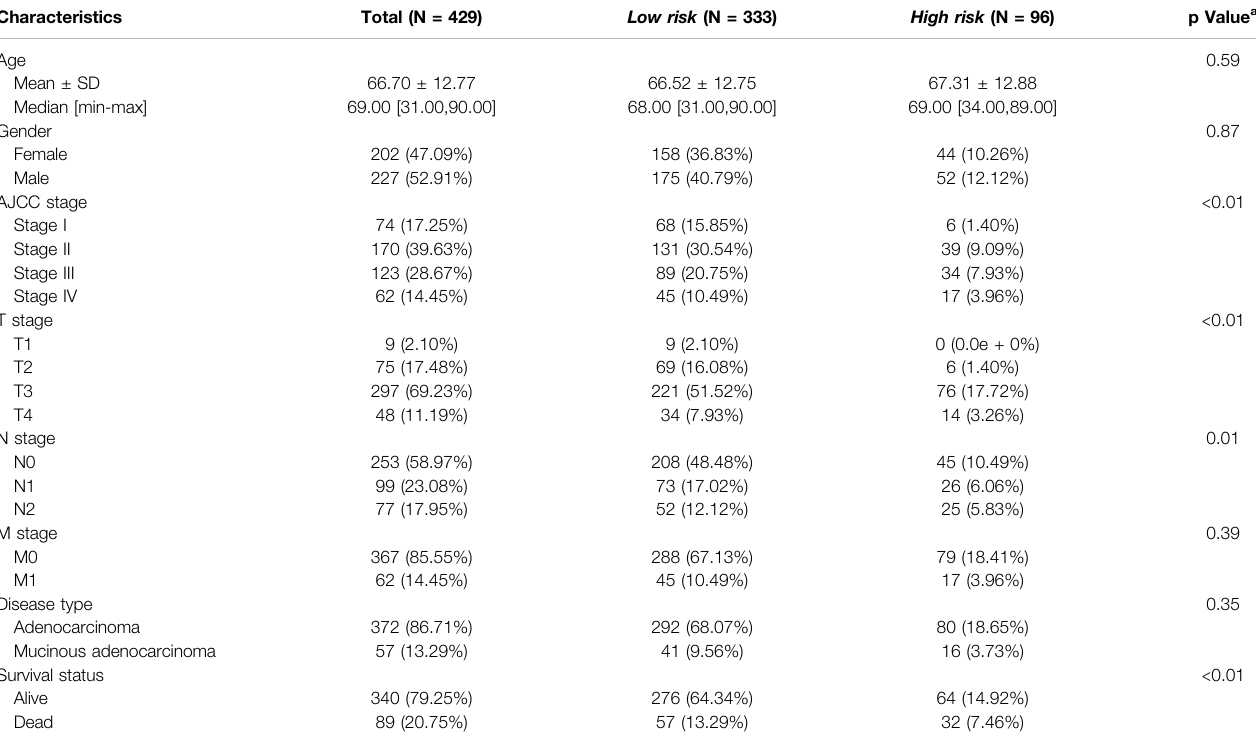
TABLE 1 | Clinicopathological characteristics between the low risk and high risk groups